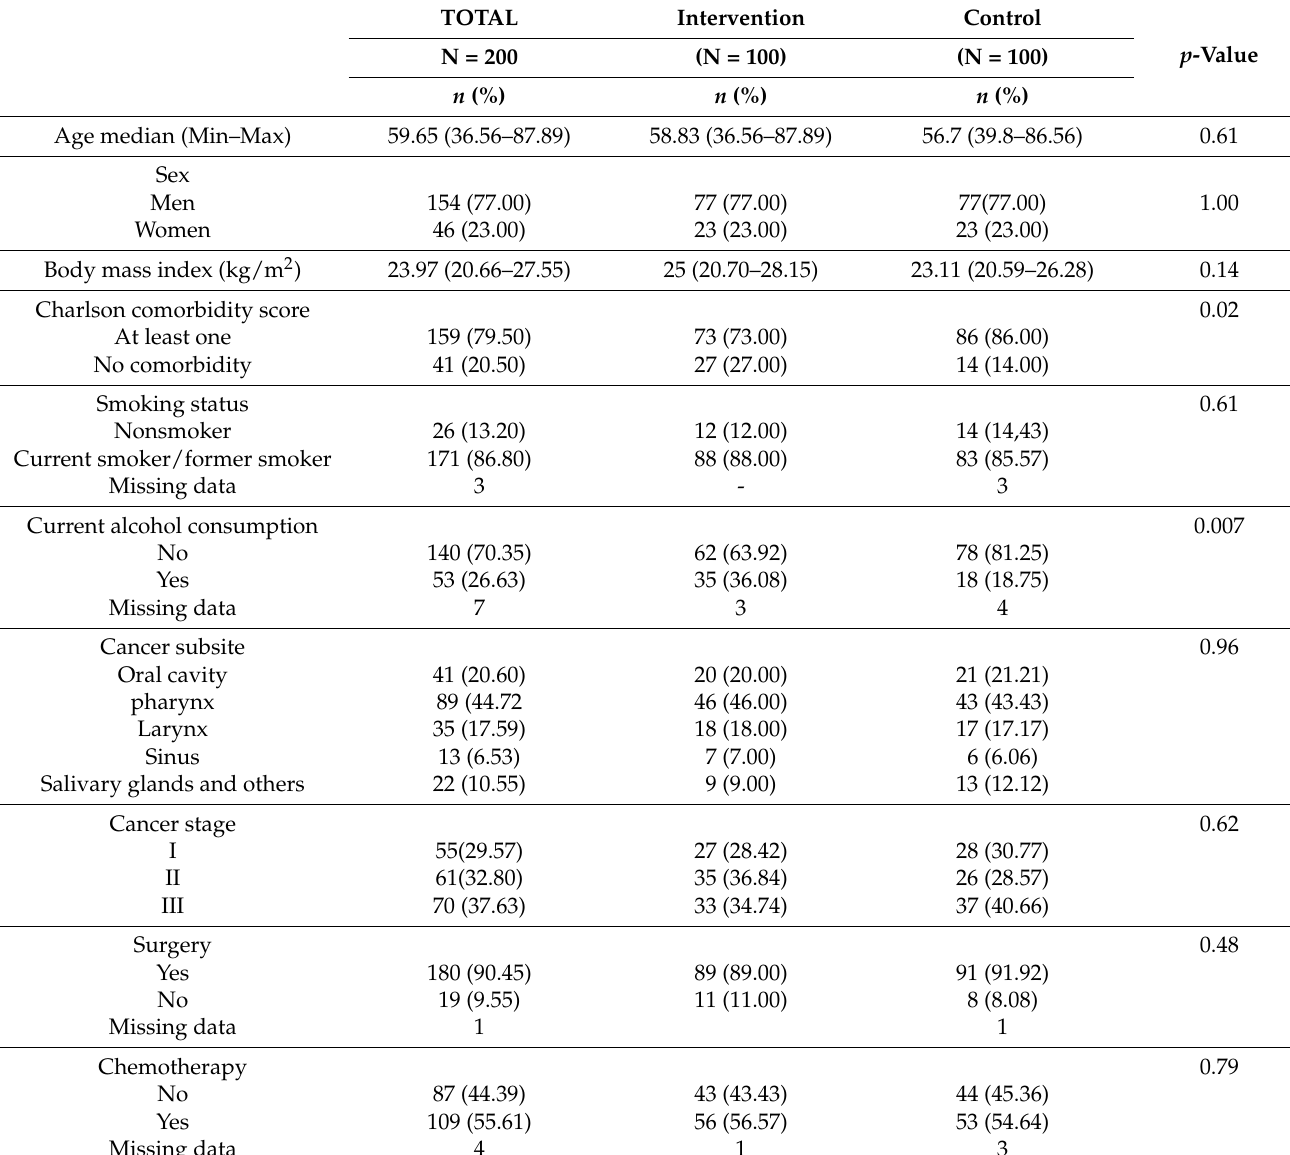
Table 2. Baseline sociodemographic and clinical characteristics.